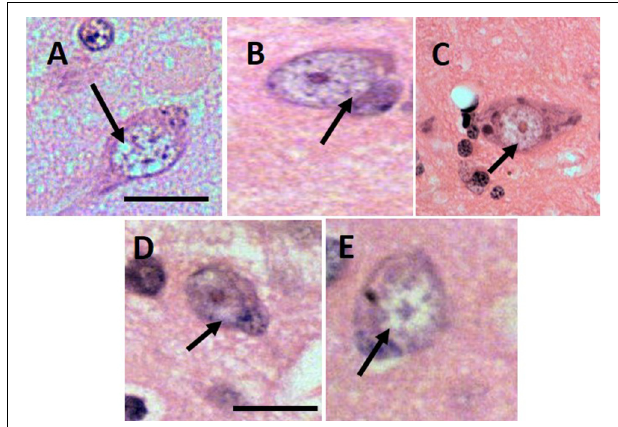
FIGURE 1 | Lesion of granulovacuolar degeneration (GVD) from 9661 (A) , 10749 (B) , I1112 (C) , T3311 (D) , 10063 (E) . Arrows indicate the suspected GVD lesion. Scale bars: 20 µ m.